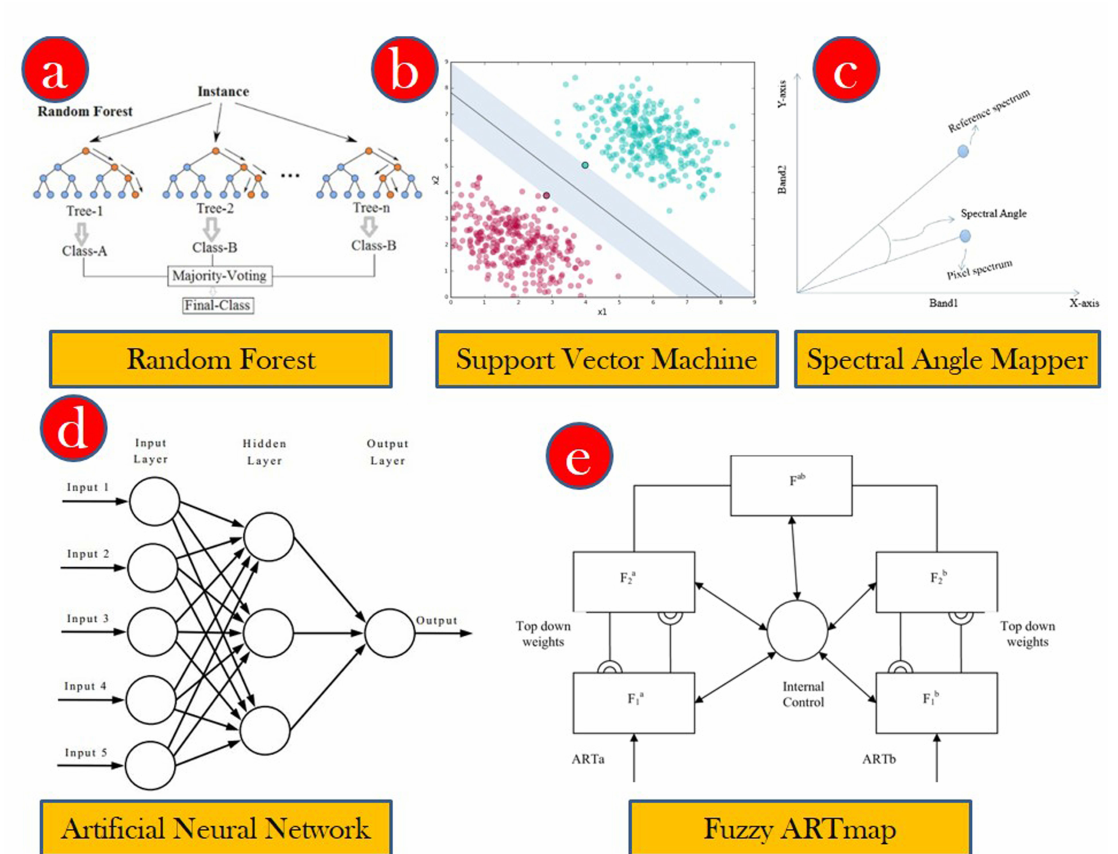
Figure 3. Schematic architecture of land use land cover classifiers ( a ) random forest, ( b ) support vector machine, ( c ) spectral angle mapper, ( d ) artificial neural network, and ( e ) fuzzy